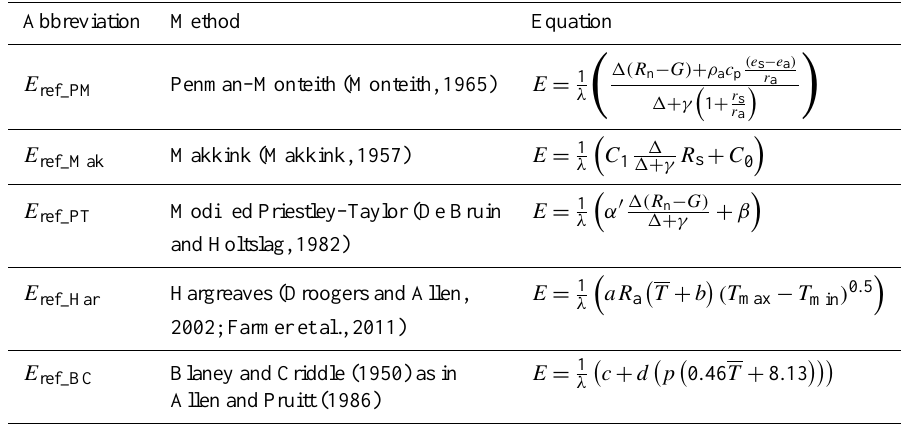
Table 1. Equations used to calculate daily values of reference evaporation E ref (mmday − 1 ) for the period 1906–2013 at De Bilt meteoro- logical